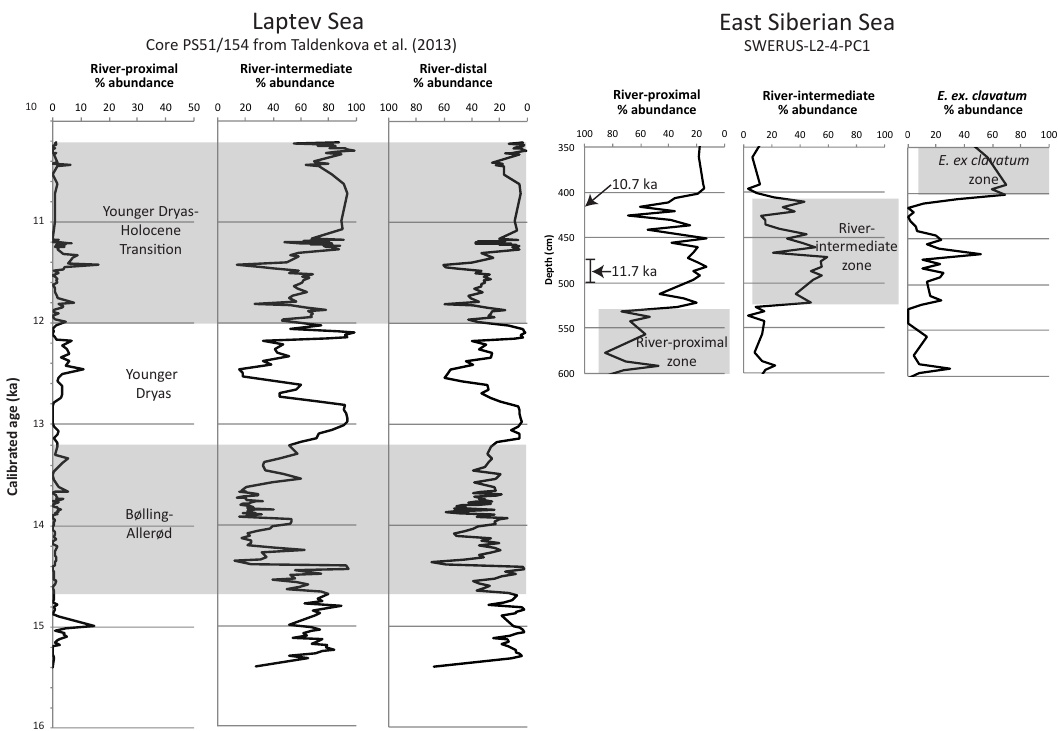
Figure 7. Comparison of benthic foraminifers in cores SWERUS-L2-4-PC1 and PS51/154 from the Laptev Sea (Taldenkova et al., 2013) using the assemblage scheme of river-proximal, river-intermediate, and river-distal taxa defined by Polyak et al. (2002). The shading marks key climatic intervals identified by Taldenkova et al. (2013) and informal foraminiferal zones in core 4-PC. River-proximal species dominate from 530 to 600cm of core depth in 4-PC1 on the East Siberian Sea margin. In contrast, river-proximal species are generally rare (usually <10%) in PS51/154 due to the greater water depth (270m) and distance from shore for the core site compared to SWERUS-4-PC1 (120m). Overlying the river-proximal zone in 4-PC1 is an interval with greatly increased proportions (40–50%) of river-intermediate species, sug- gesting deeper water due to regional sea level transgression. This zone is dated at 12 to 10.7ka, mainly the post-Younger Dryas and transition into the Holocene (Preboreal) period. Oscillations in foraminiferal assemblages in core PS51/154 coincide with those in SWERUS-4-PC1; however, those in PS51/154 signify water mass changes on the upper slope rather than salinity changes due to changes in the rate of sea level rise and proximity to freshwater river influx. Late Holocene foraminiferal assemblages at 4-PC1 (not shown) are dominated by E. excavatum clavata